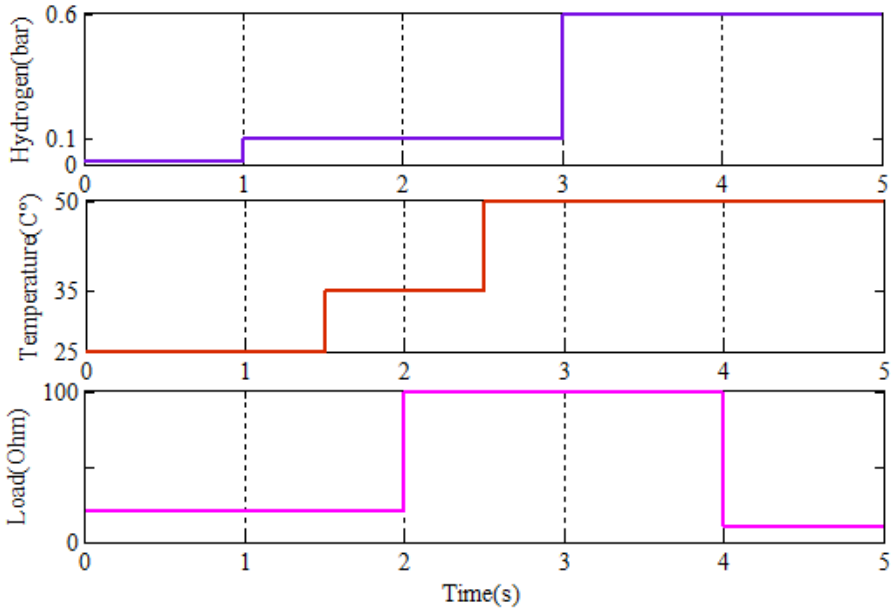
Figure 13. Load, temperature, and hydrogen